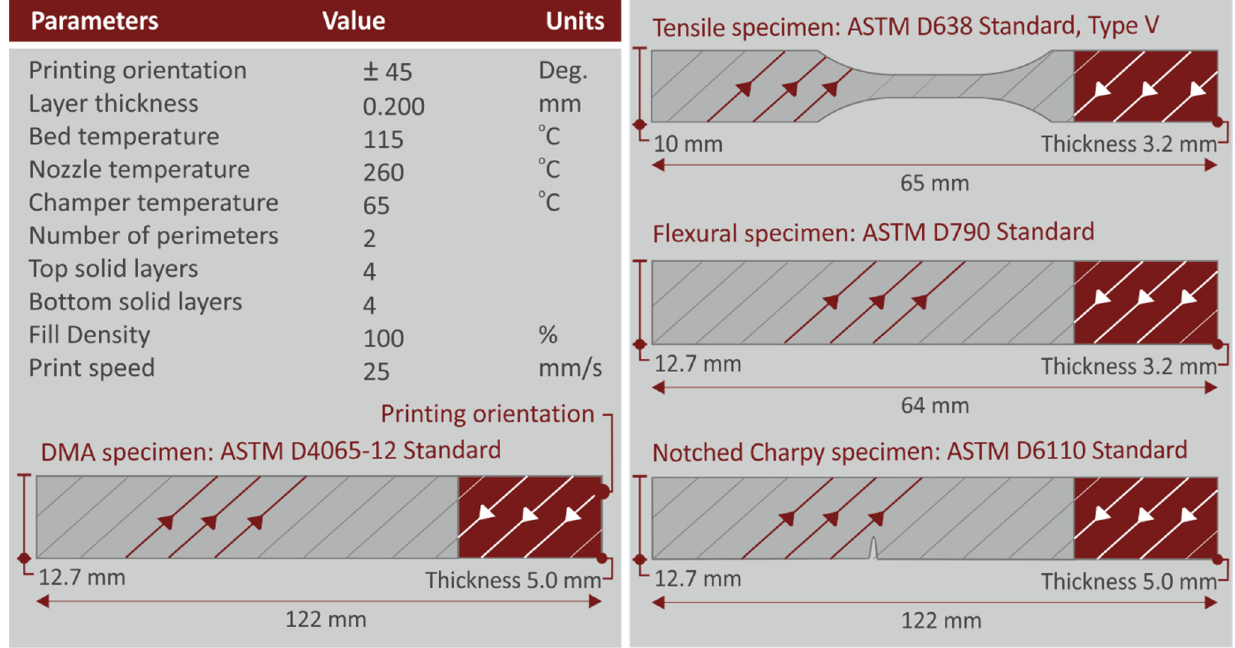
Figure 2. The 3D printing parameters for the manufacturing of specimens. The specified dimensions of the fabricated specimens for each mechanical test are presented on the right side.